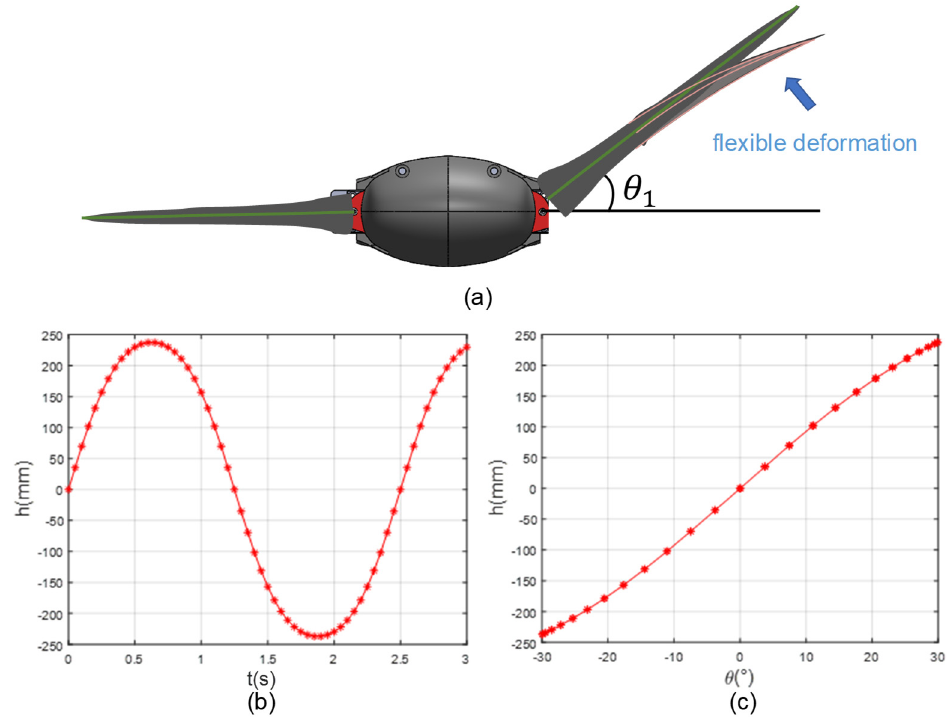
Figure 4. Analysis of pectoral fin flexible deformation. ( a ) Schematic diagram of passive deformation of pectoral fins; ( b ) The graph of h i versus time; ( c ) The graph of h i versus output angle.